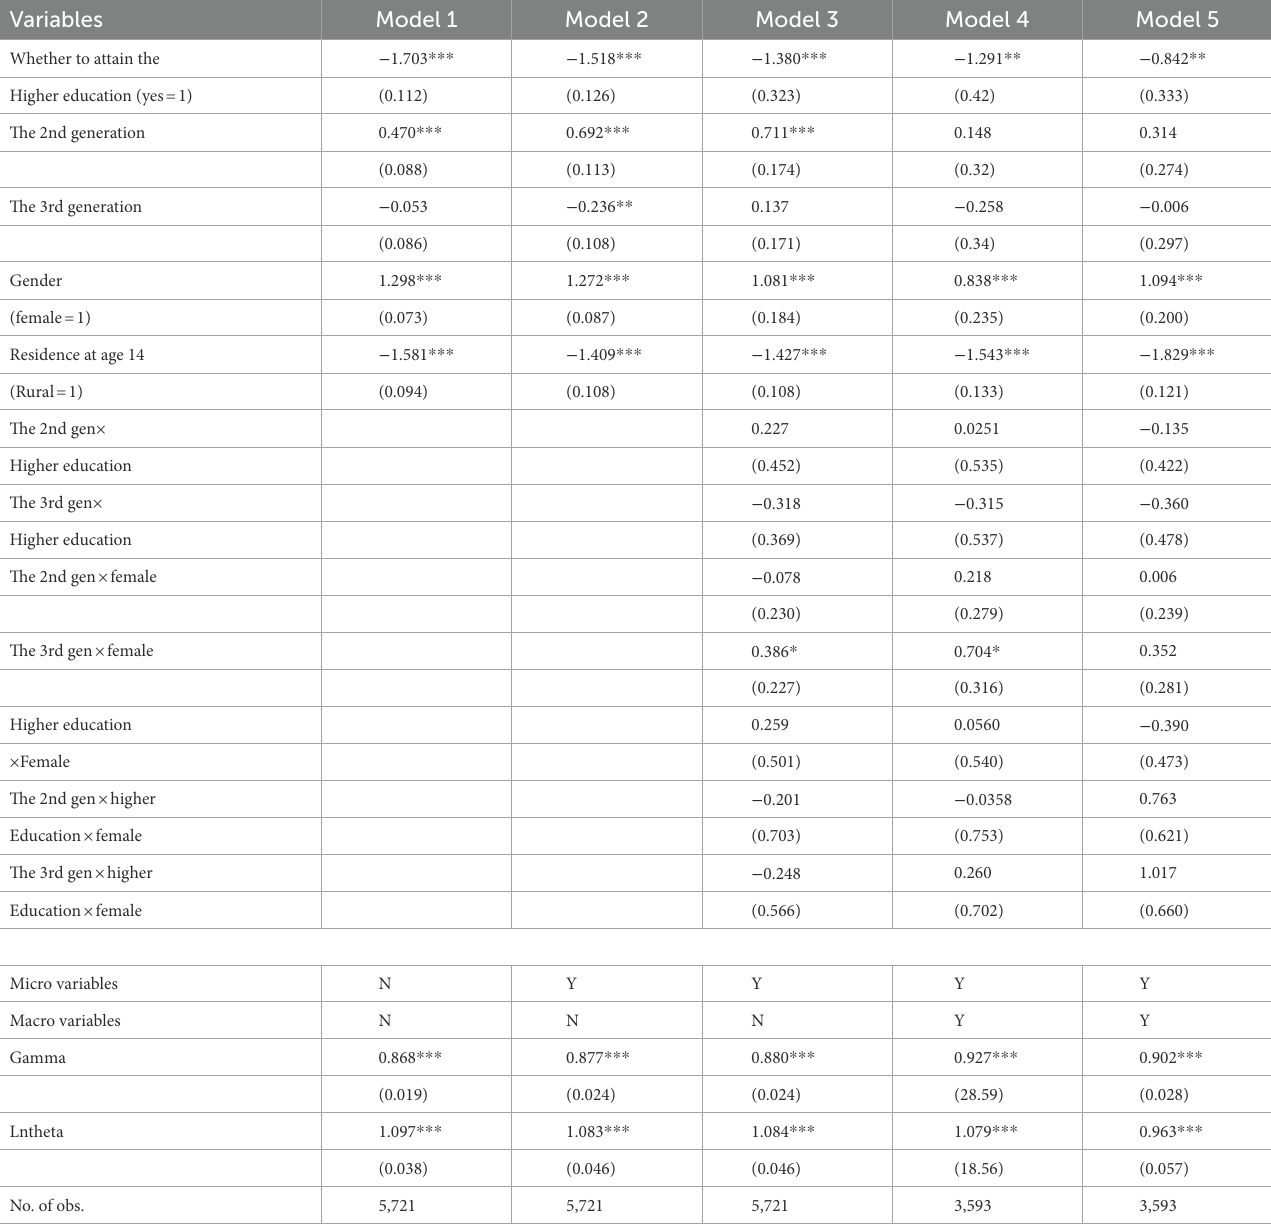
TABLE 2 Analysis of influencing factors of the average age of the first